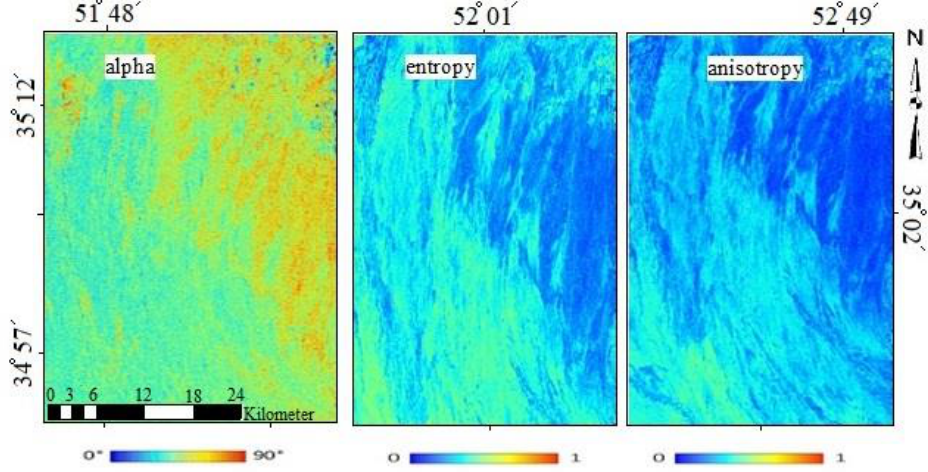
Figure 6. The HH polarization of quad pol PALSAR data on the left, the Pauli RGB (color coded as red = |HH − VV|, green = |HV|, and blue = |HH + VV|) in the middle, and the Span total power image on the right.